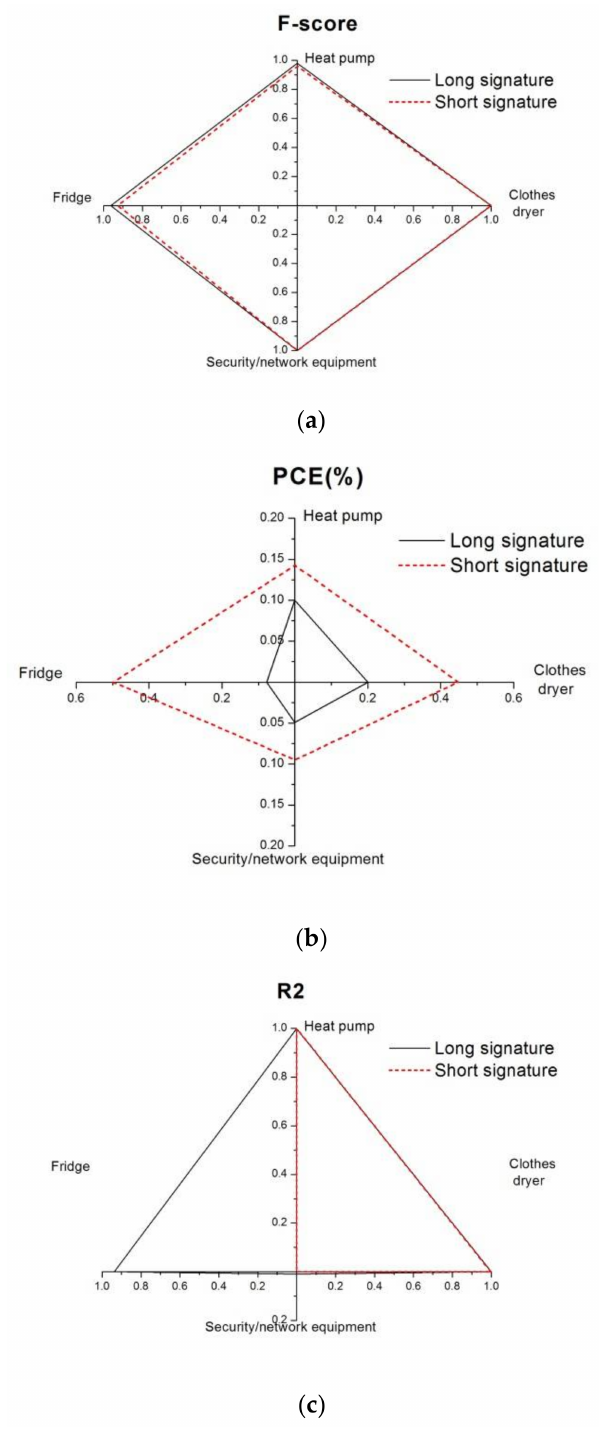
Figure 7. This is disaggregation accuracy metrics for ILDACP with a long signature (a week data) and a short signature (an operating duration data). From top: ( a ) F-score; ( b ) PCE; and, ( c )